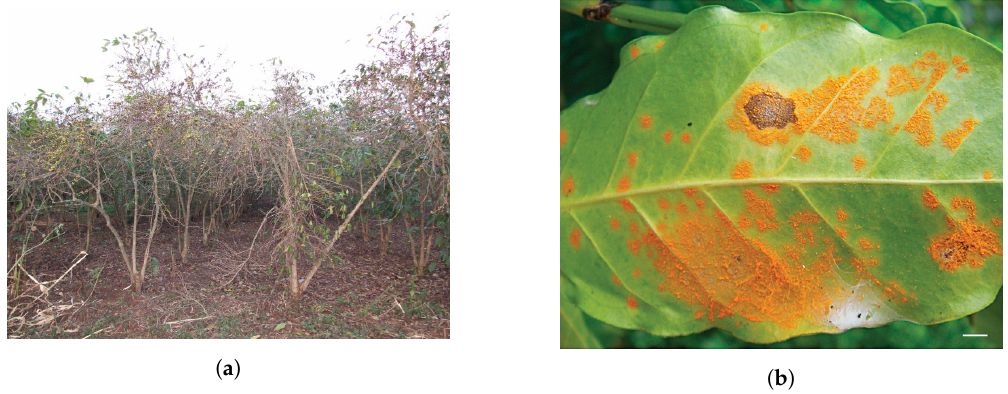
Figure 1. Coffee Leaf Rust (CLR) effects: ( a ) on the Caturra variety crops; ( b ) on a leaf at the disease’s highest development stage